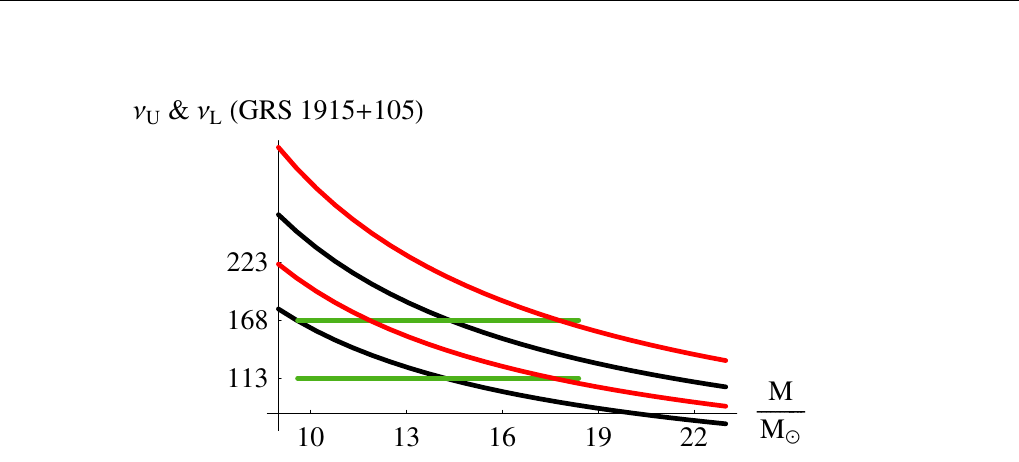
Figure 10. Fitting the particle oscillation upper and lower frequencies to the observed frequencies (in Hz) for the microquasar GRS 1915+105 at the 3/2 resonance radius. In the black plots the microquasar is treated as a quantum deformed Kerr BH given by (76) with b 0 = 0.6035. The upper black curve represents ν U = ν θ and the lower black curve represents ν L = ν r with ν U / ν L = 3/2, and the green curve represent the mass error band as given in (78). The black curves cross the mass error bands well in the middle ensuring a good curve fitting. In the red plots the microquasar is treated as a Kerr BH b 0 = 0. The red plots also cross the mass error bands but at the rightmost points. A description of the astrophysical object by a Kerr BH does not provide a good curve fitting to justify the occurrence of the 3/2 resonance.